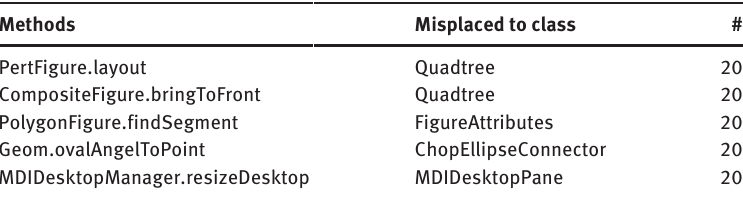
Table 5. Manually Misplaced Methods for JHotDraw. Methods